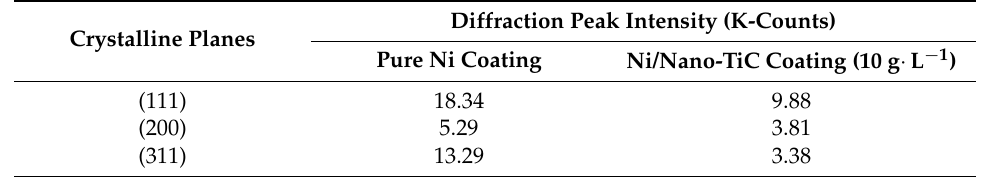
Crystalline Planes